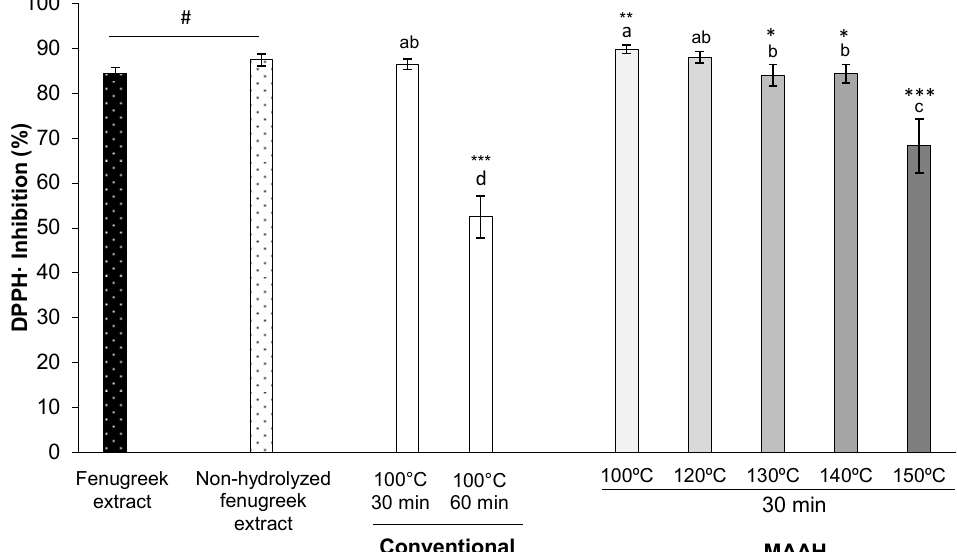
Figure 7. Effect of temperature on the DPPH radical scavenging activity (%) of fenugreek extracts and sapogenin-rich extracts obtained by conventional hydrolysis and microwave-assisted acid hydrolysis (MAAH). Standard deviations are indicated by error bars. Mean values with different letters are significantly different ( p ≤ 0.05) and mean values are significantly different from the non-hydrolyzed fenugreek extract if p ≤ 0.05 (*), p ≤ 0.01 (**) and p ≤ 0.001 (***). Non-hydrolyzed fenugreek extract is different from fenugreek extract (#, p ≤ 0.001). “Fenugreek extract” refers to the commercial saponin mixture as received from the supplier. “Non-hydrolyzed fenugreek extract” refers to the “fenugreek extract” extracted with ethyl acetate at time 0 of hydrolysis.